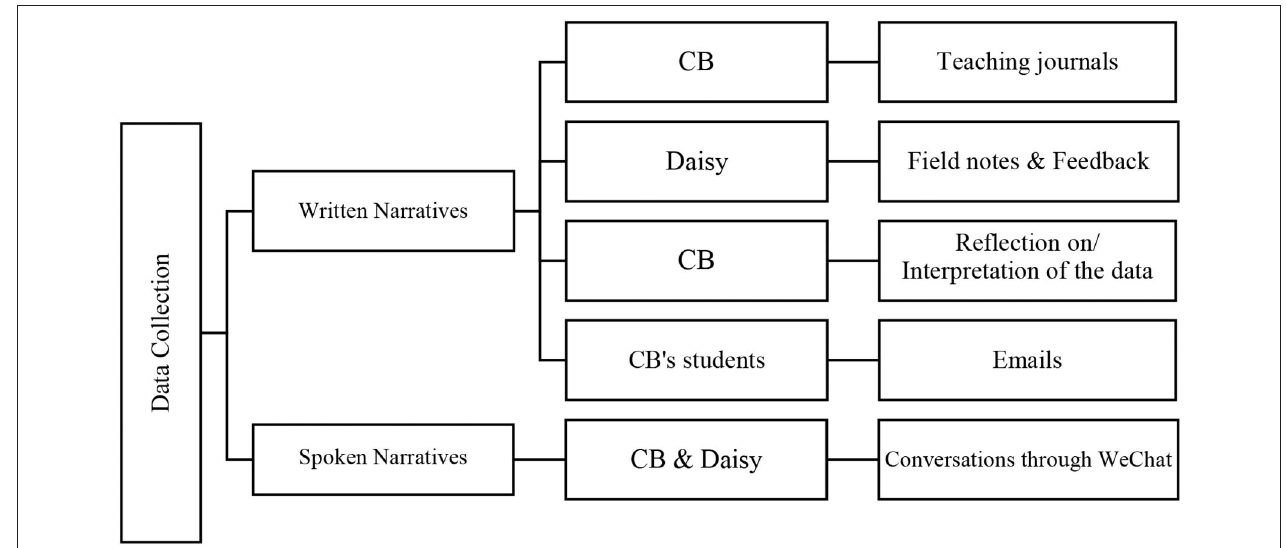
FIGURE 2 | Data sources.